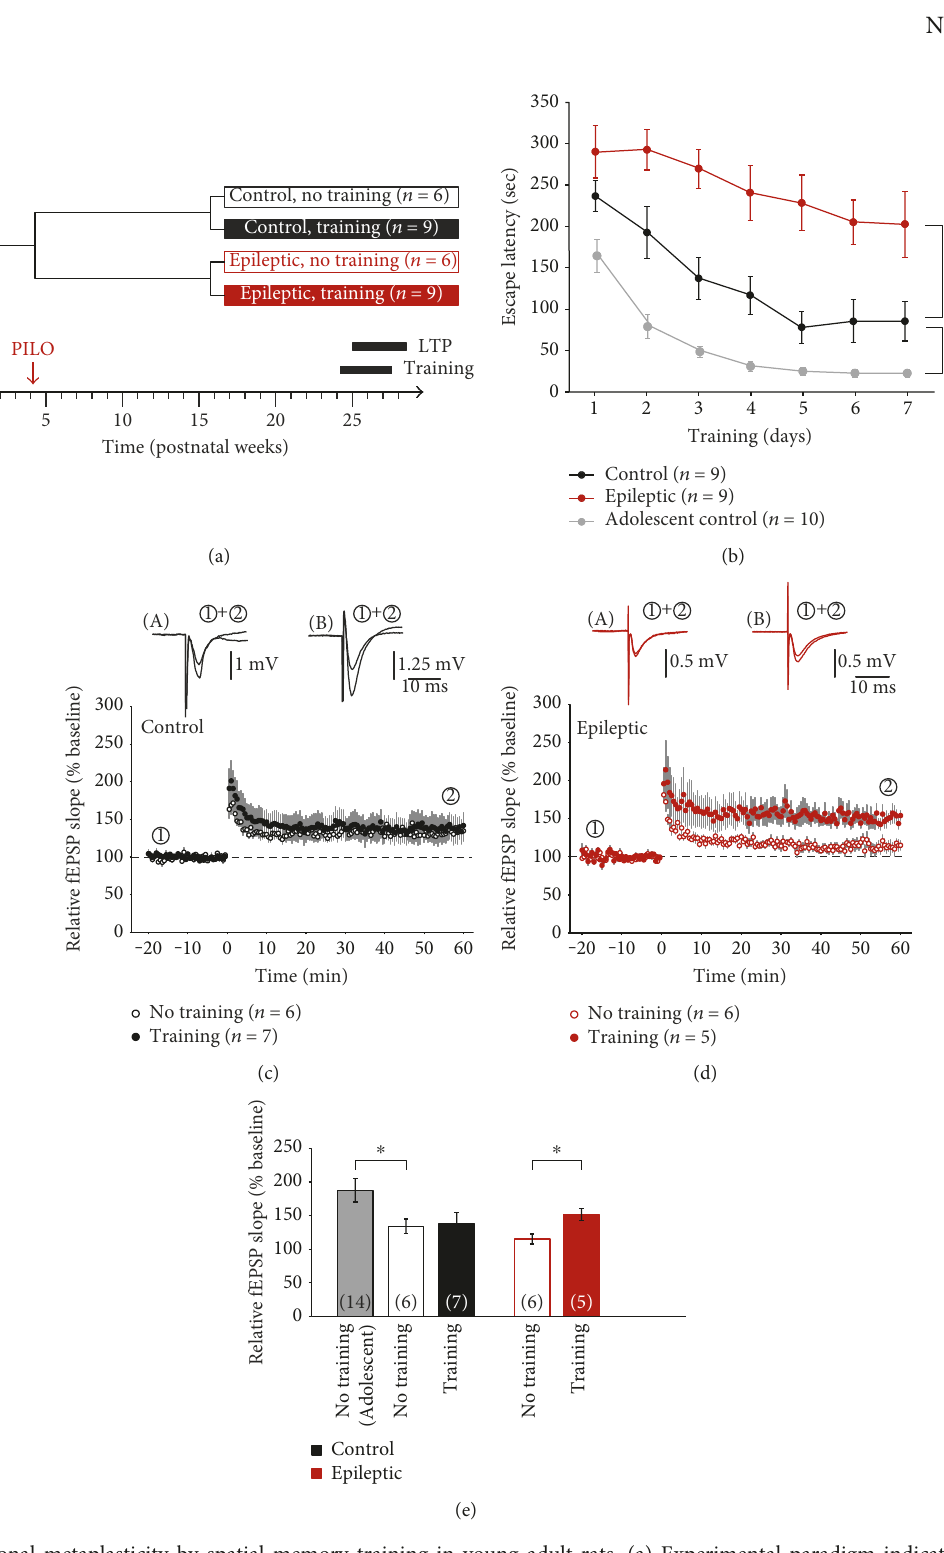
Figure 2: Functional metaplasticity by spatial memory training in young adult rats. (a) Experimental paradigm indicating pilocarpine- induced status epilepticus ( “ PILO ” ) and time points of both training and LTP in four groups of animals (control and epileptic rats, with or without training). (b) Spatial memory acquisition was again signi fi cantly impaired in epileptic animals (red symbols) compared to controls (black symbols). Moreover, there was also a signi fi cant di ff erence between adolescent (gray symbols, data taken from Figure 1(b) for the sake of clarity) and young adult control animals (black symbols). (c, d) Spatial memory training ( fi lled symbols) had no e ff ect on subsequent CA1-LTP in vitro in controls but signi fi cantly enhanced CA1-LTP in young adult epileptic animals. (e) Bar graphs summarizing CA1-LTP levels of the four groups of animals. In addition, LTP data from adolescent controls taken from Figure 1(e) is given for comparison. ∗ P < 0 05